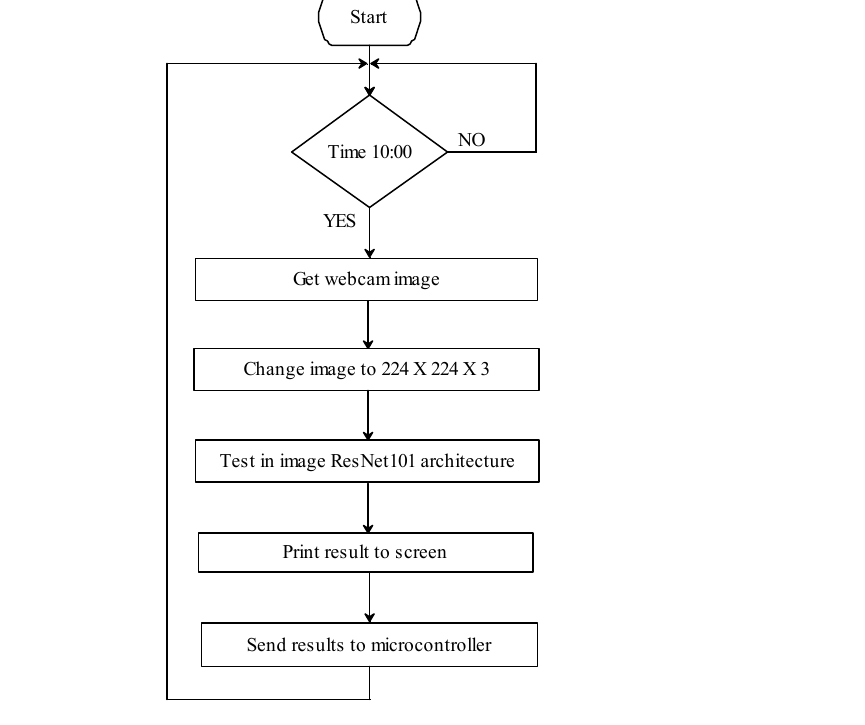
Figure 18. Deep learning test algorithm. Appl. Sci. 2022 , 12 , x FOR PEER REVIEW